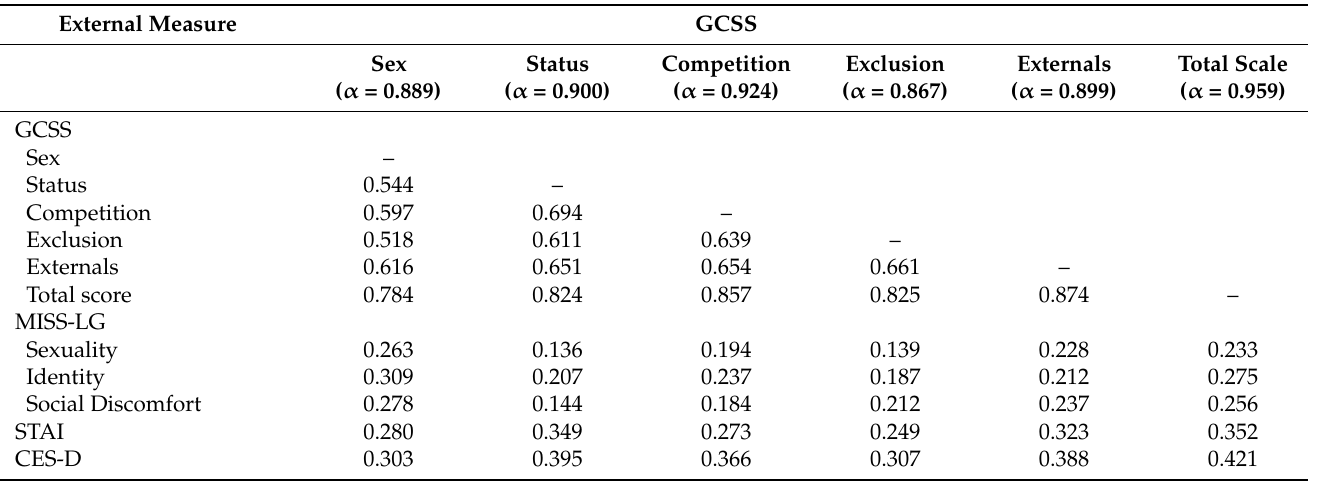
Table 4. Concurrent validity and internal consistency of the Gay Community Stress Scale